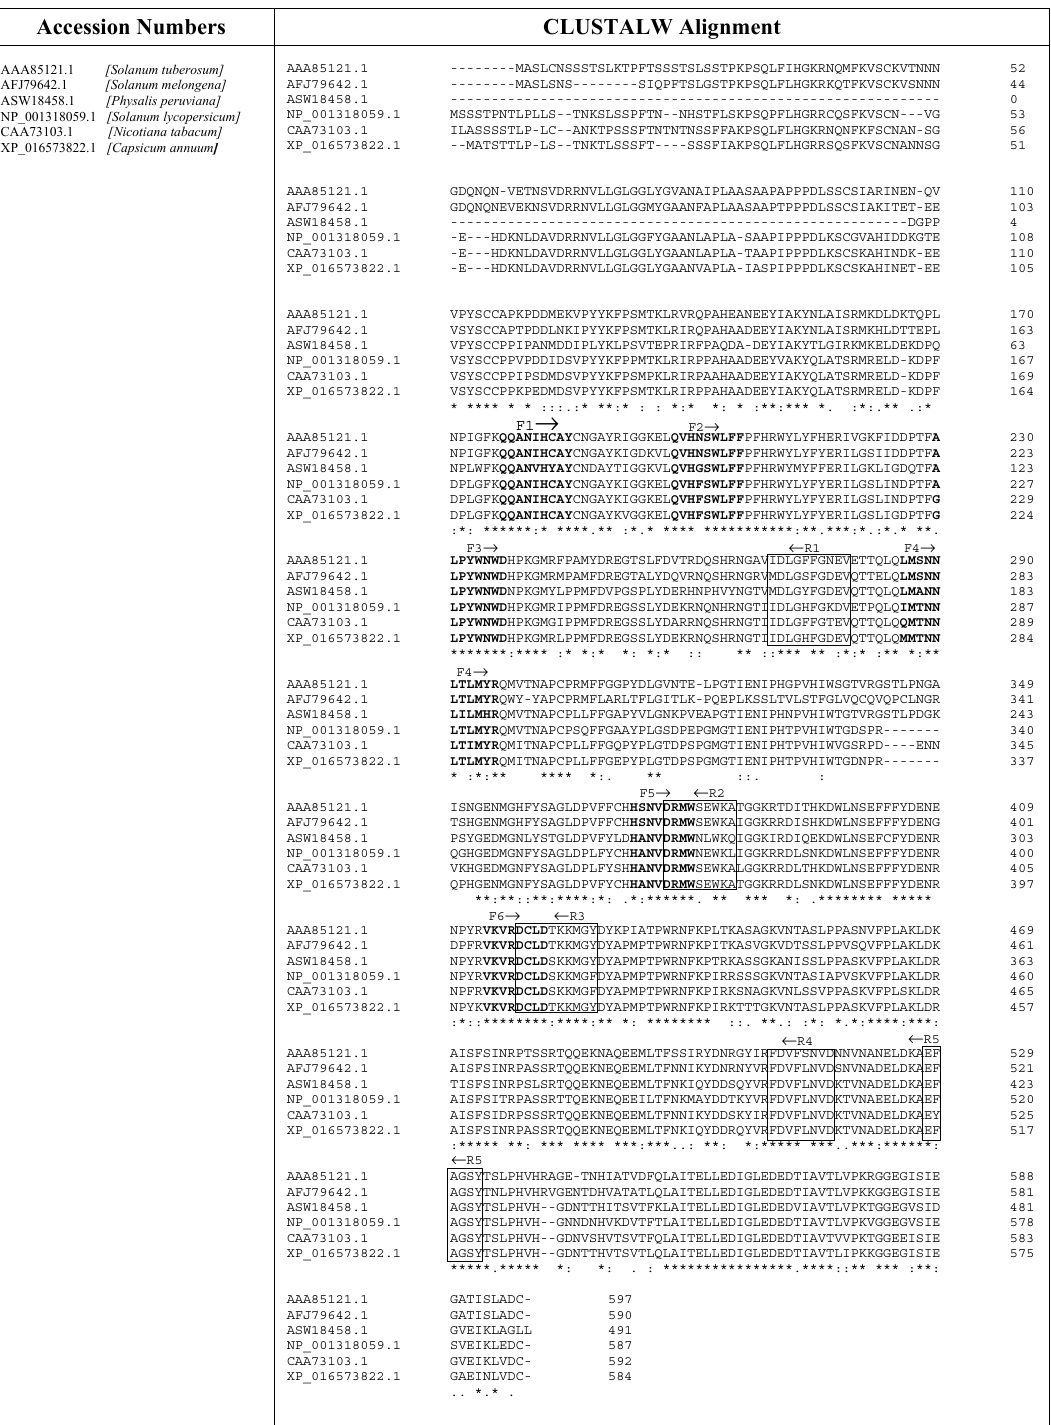
Figure 3. Multiple alignment of PPO amino acids from six different plant sources. The sequences were chosen from the GenBank SwissProt database and aligned using Clustal Omega tool. An asterisk (*) denotes identical residues; double dots (:) represent a conserved residue substitution; a single dot (.) shows partial conservation of the residue. The arrow above the amino acid sequences indicates the position of the sense (F → ) and antisense ( ← R) primers chosen from a group of candidate primers obtained from the CODEHOP program. The sequences of the sense and antisense primers were obtained from the Clustal Omega alignments shown in bold and inside the boxes, respectively. Supplementary Materials: The following are available online at www.mdpi.com/xxx/s1: Figure S1: Electrophoretic separation on 6% polyacrylamide gel of the PCR product obtained for the polyubiquitin gene